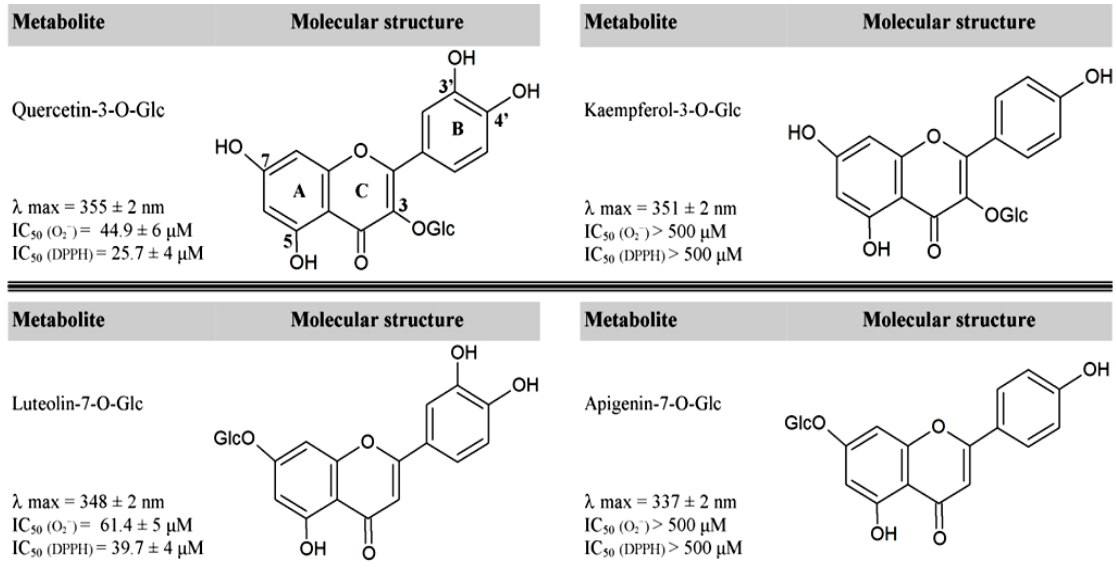
Figure 1. Absorbance maxima and ROS-quenching capacity of mono-(apigenin and kaempferol) and dihydroxy B-ring-substituted (quercetin and luteolin) flavonoid glucosides (glc). Absorbance spectra were recorded in phosphate buffer at a metabolite concentration of 50 µM. IC denotes the molar concentration required to reduce by 50% the 50 concentrations of superoxide anion (O 2− ) and the synthetic free radical DPPH (2,2-diphenyl-1-picrylhydrazyl) as estimated following the protocols reported in